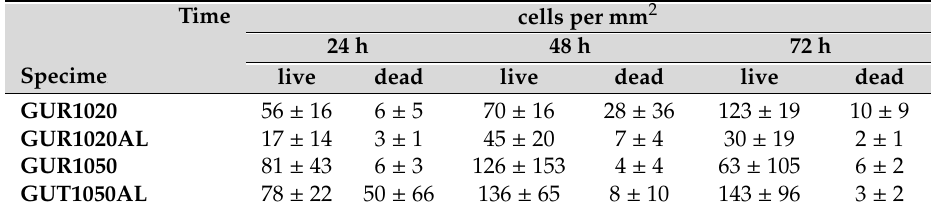
Table 6. Overview of GUR specimen cell counts [N = 10].